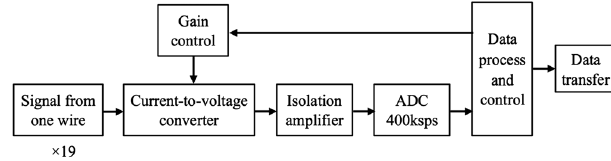
FIG. 7. Schematic design of the electronics system for the wire scanner monitor.